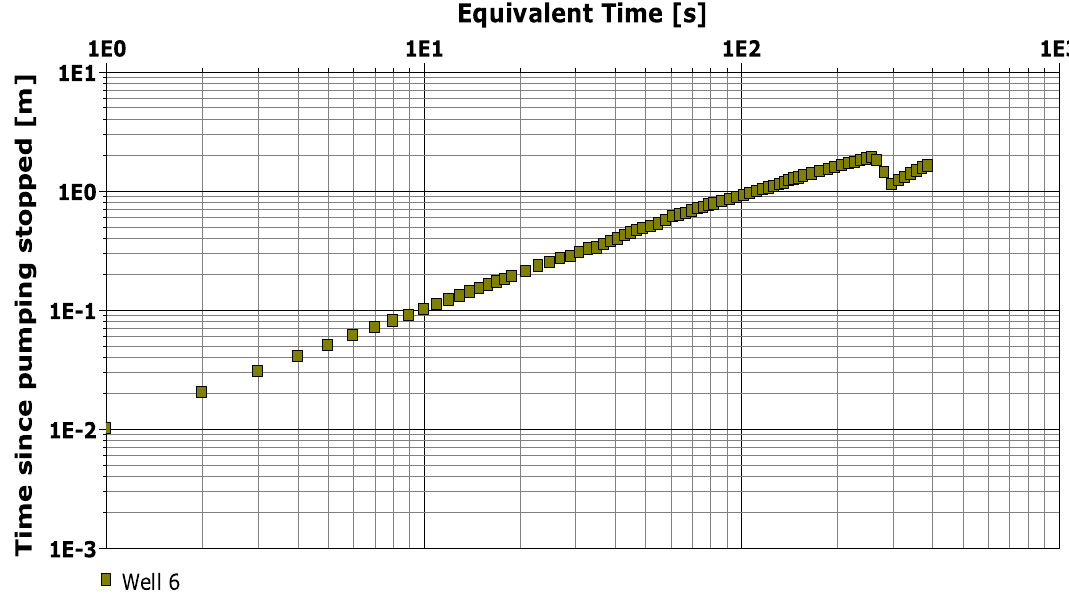
Fig. 11 Plotting of recovery rate of well-6 using aquifer mapping software